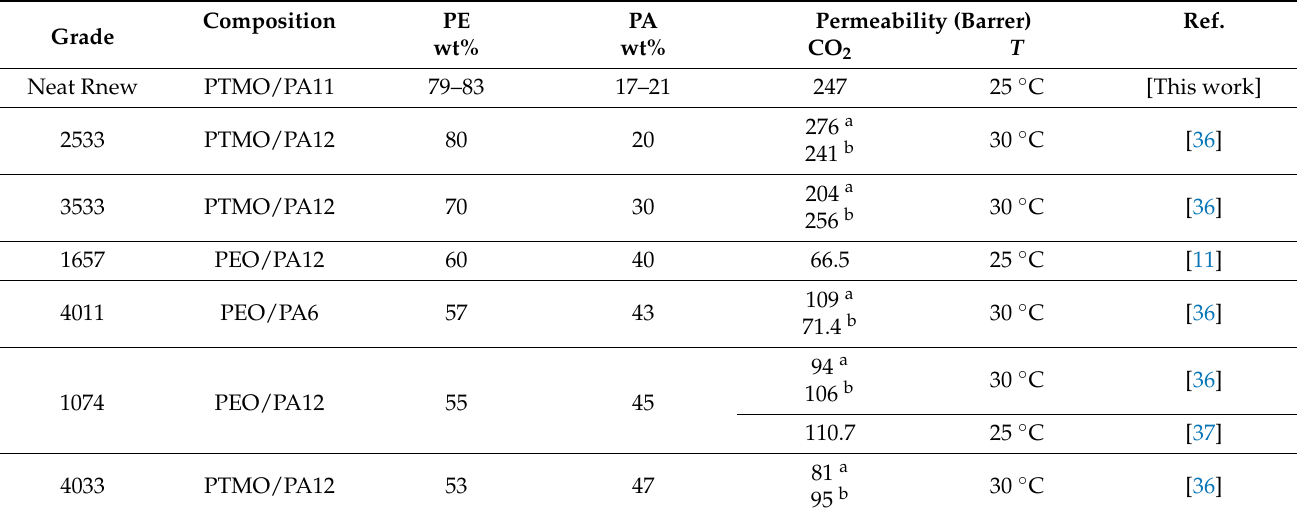
Table 3. Composite different Pebax ® grades and gas permeability for measured in the corresponding